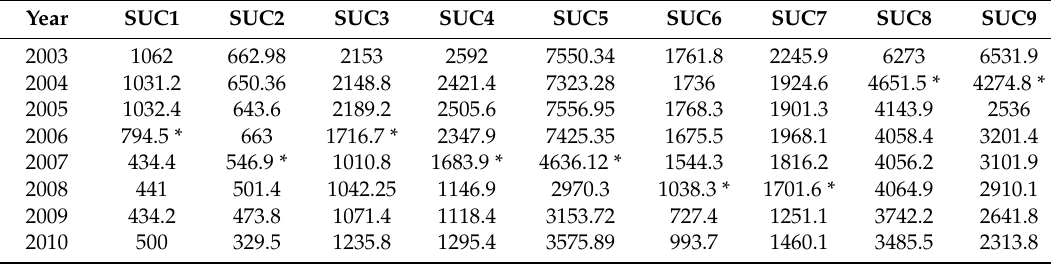
Table 3. Annual Energy Consumption ( Q p or Q (cid:48) p ) [GJ / a] for heating purposes in the particular year of the conducted examination read by the heat-meters.